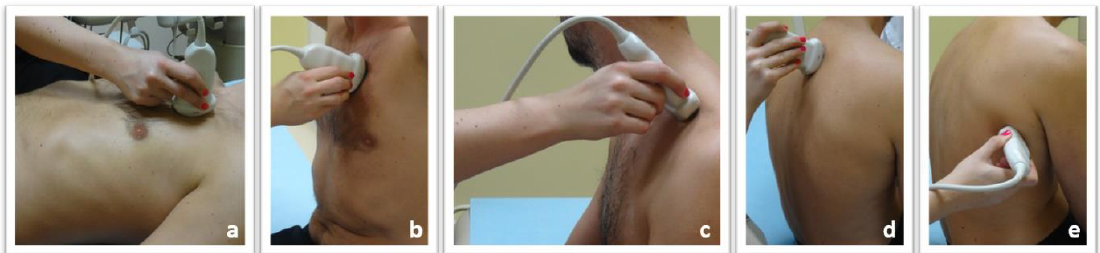
Figure 2. Lung ultrasound technique for internal medicine patients: Lung ultrasound examination in patients with internal diseases is performed with the convex and linear probe, in the supine and/or sitting position: ( a ) Scanning the anterior chest wall in the supine position; ( b ) Scanning the anterior chest wall while seated; ( c ) Assessment of the peaks through the supraclavicular fossa; ( d ) Assessment of the posterior chest wall in a sitting position; ( e ) Assessment of the posterolateral thoracic wall in a sitting position.